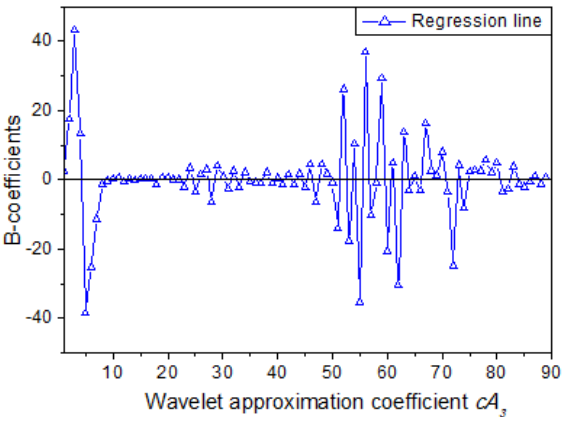
Figure 7. B-coefficients of the optimal determination Model 6.